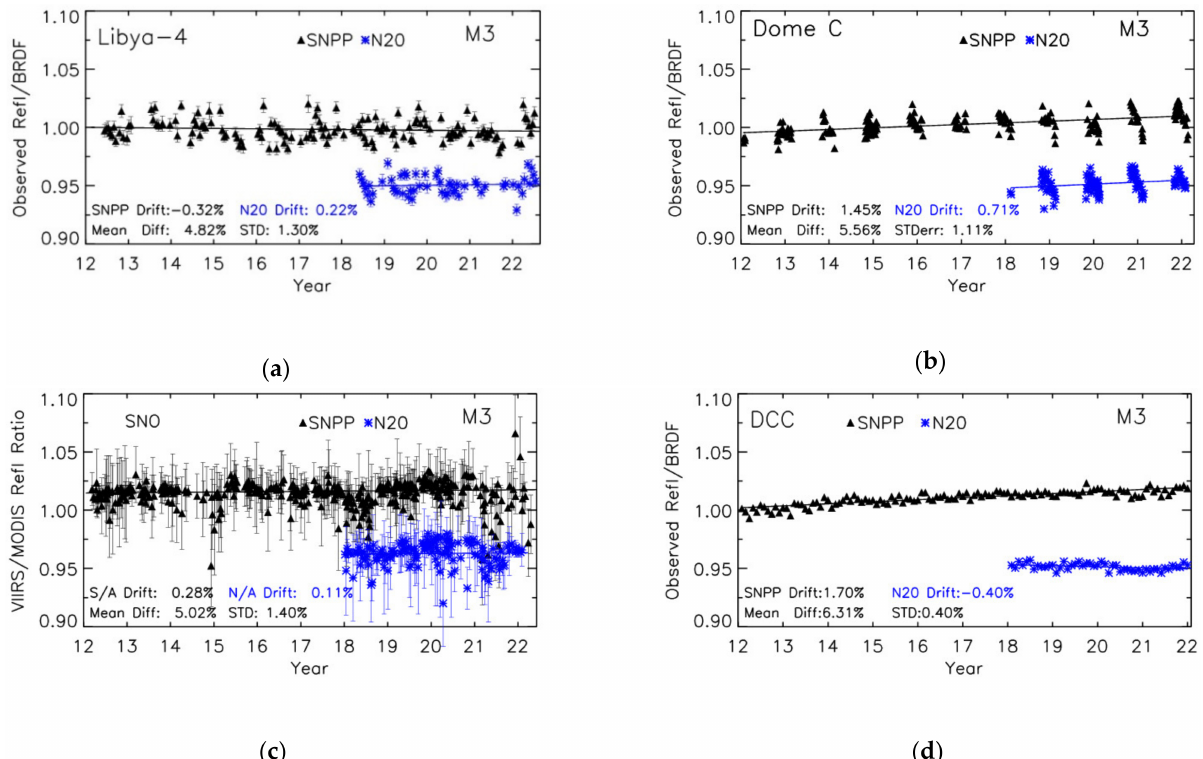
Figure 4. Normalized reflectance trends for SNPP and NOAA20 VIIRS M3 obtained from the Libya-4 ( a ), Dome C ( b ), SNO with Aqua MODIS ( c ), and DCC ( d